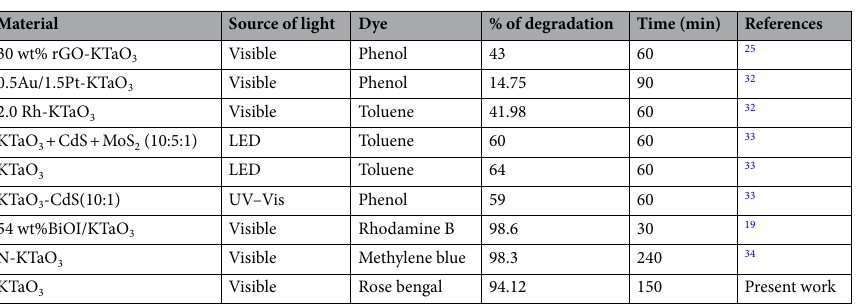
Table 1. Literature survey with degradation of different pollutants by KTaO 3 and its composites.